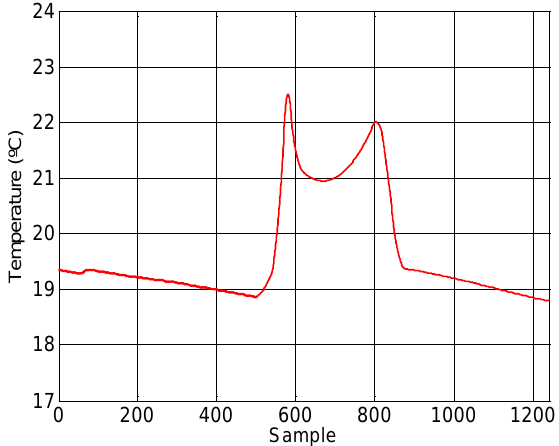
Figure 6. Raw temperature samples obtained during the